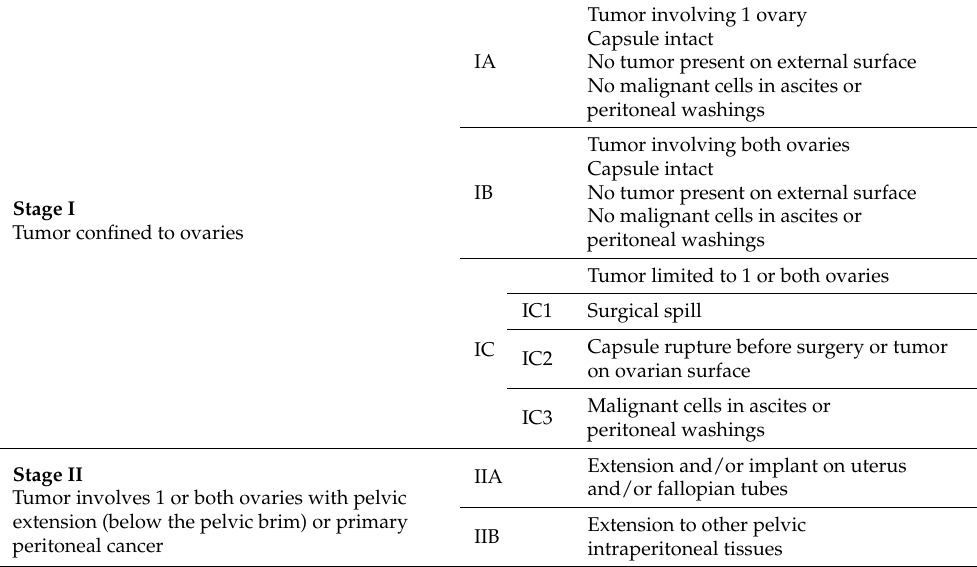
Table 1. FIGO staging of ovarian cancer, 2014